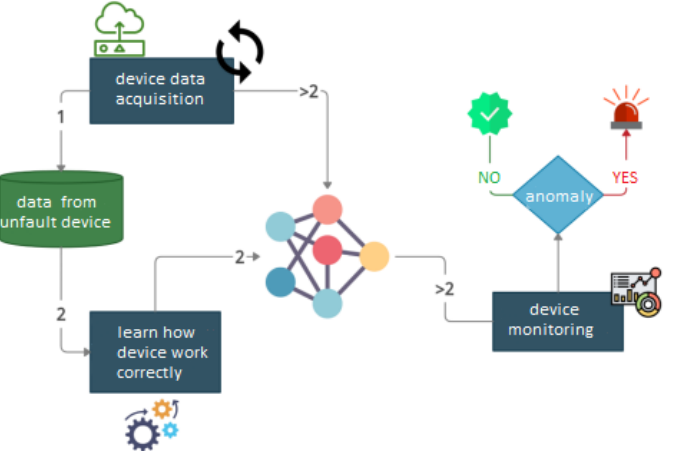
Figure 1. An overview diagram of the process of learning the correct device by the algorithm and on-line monitoring. Numbers 1 and 2 mean consecutive steps and “>2” system operation after initial configuration.